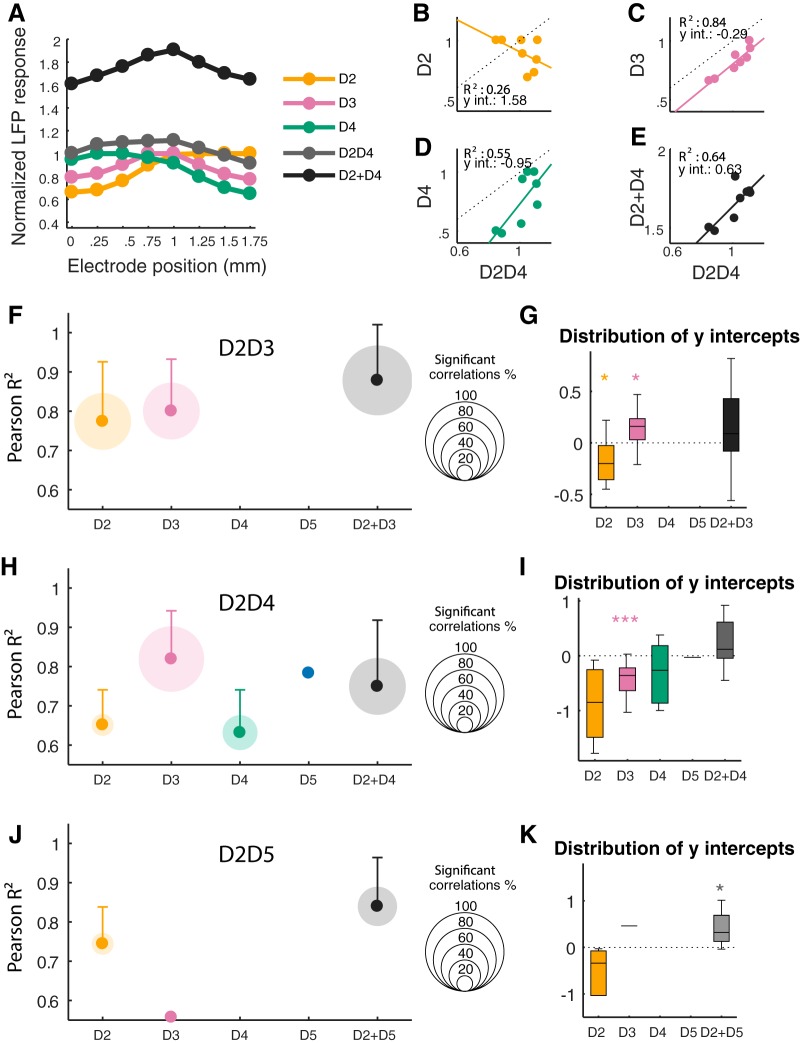
Regression analysis of LFP. A, Example of mean LFP responses according to recording electrode position (see Fig. 1). Cortical pattern of activity evoked after D2, D3, and D4 single stimulation, D2D4 costimulation, and that obtained after the sum of D2 and D4 single-digit responses (D2 + D4). B–E, Linear regression between D2D4 activity pattern and each of the patterns shown in A. Note that the D2D4 costimulation-evoked activity pattern resembled that obtained after stimulation of the center digit, D3 (C). F, H, J, Mean R2 (ordinate axis) and proportion of significant regressions (diameter of shaded discs; F test, p < 0.05) obtained in the whole neuronal population for each of the costimulation patterns (D2D3, D2D4, and D2D5). G, I, K, Y-intercept distributions of the significant regressions between costimulation and single stimulation or addition activity patterns. A negative value indicates a greater activity for the costimulation (Wilcoxon test of the median versus 0;
*p < 0.05; ***p < 0.001).